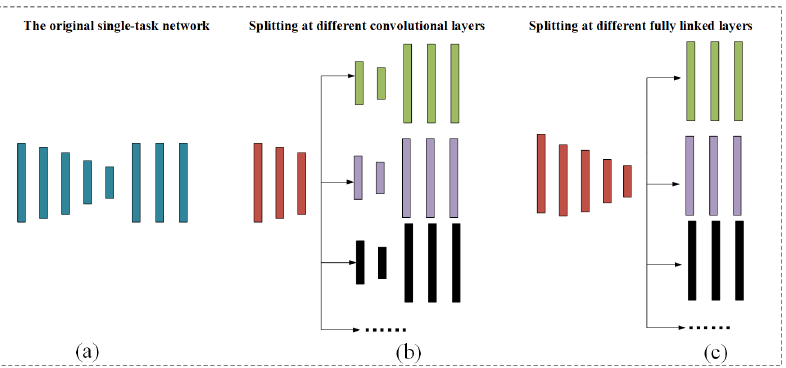
Figure 2. Different ways of parameters sharing. The subfigure ( a – c ) represents three types of struc- tures respectively: single-task networks, networks split at the convolutional layers, and networks split at the fully connected layers.